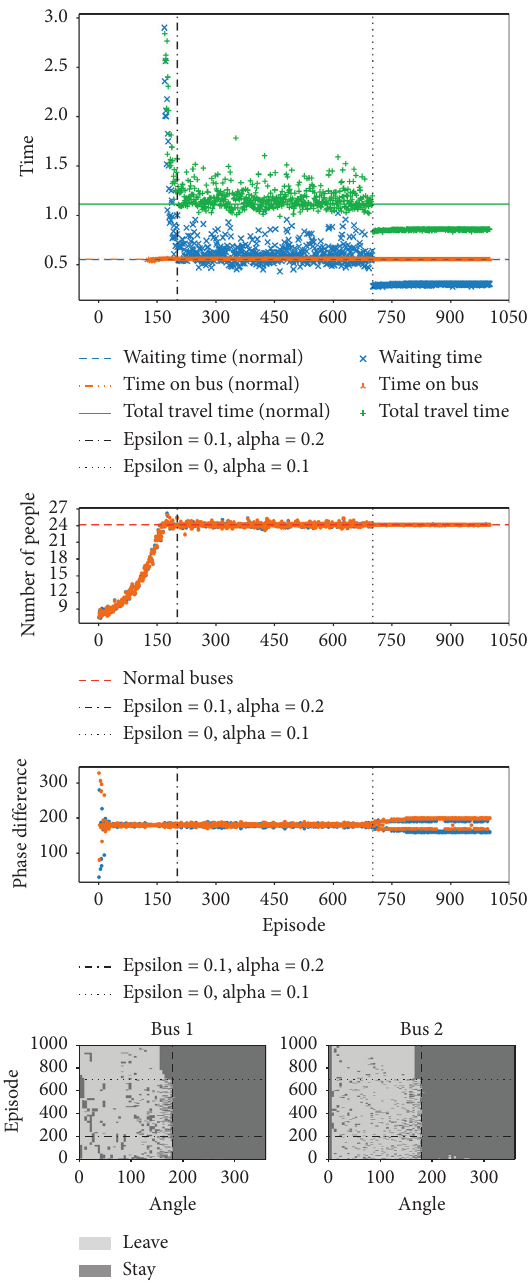
Figure 3: Two buses with identical natural frequency serving a loop of bus stops learn the no-boarding strategy by reinforcement learning. Notably, they learn about the upper bound at some angle strictly less than 180 ° to implement no-boarding, where if they exceed, then they would inadvertently implement no-boarding too frequently such that they are not meeting the level of demand for service. Also, they learn to unbunch , where one learns to stay whilst the other learns to leave , if their phase difference is 0 °